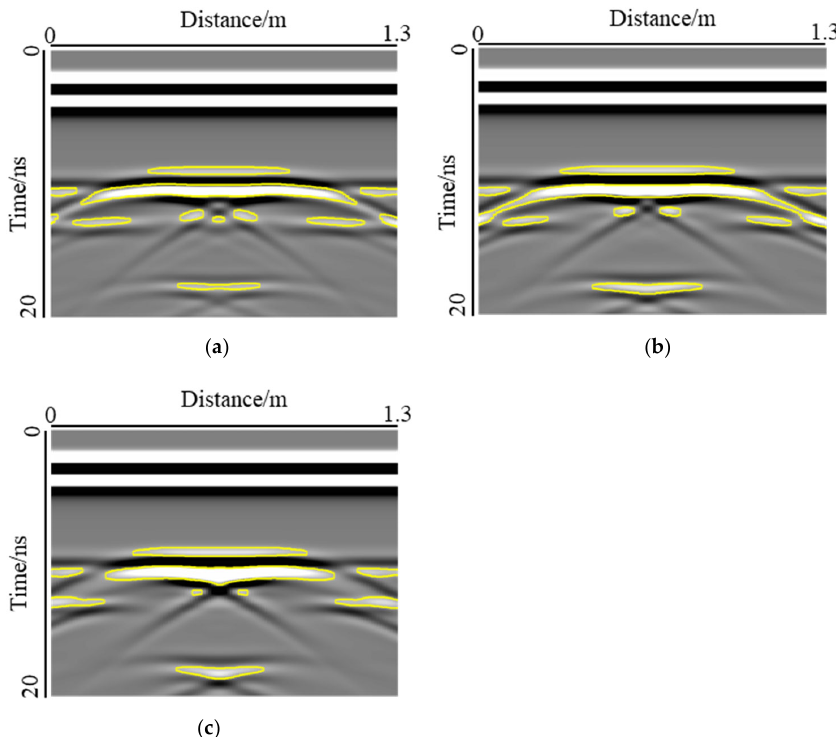
Figure 15. Effect of thickness on the extension area of the void response: ( a ) Bowl-shaped, h s = 0.05 m; ( b ) Bowl-shaped, h s = 0.10 m; ( c ) Strip-shaped, h s = 0.15 m. This figure shows the different response of the void when the thickness changed.